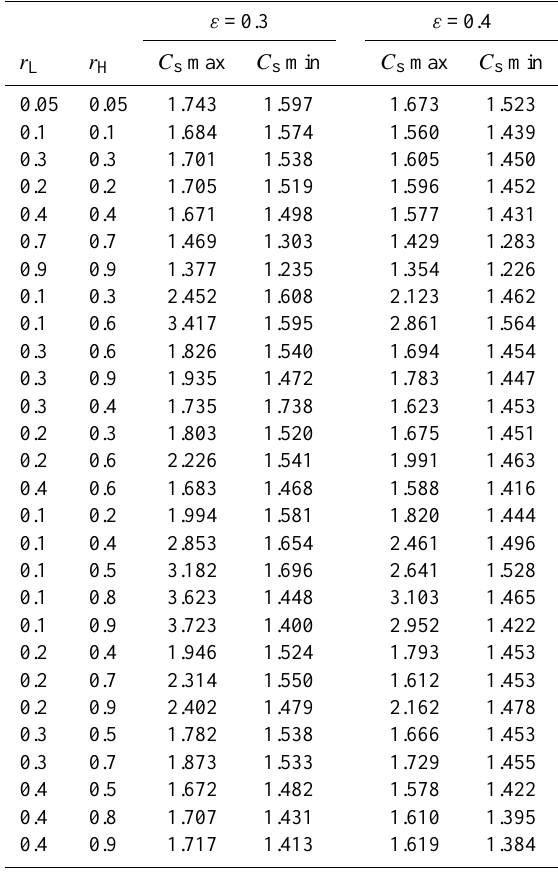
Table 11. Minimum and maximum skewness coefficient obtained for different values of r L and r H ; for 3 p =21, and ε =0.3 or ε =0.4. ε =0.3 ε